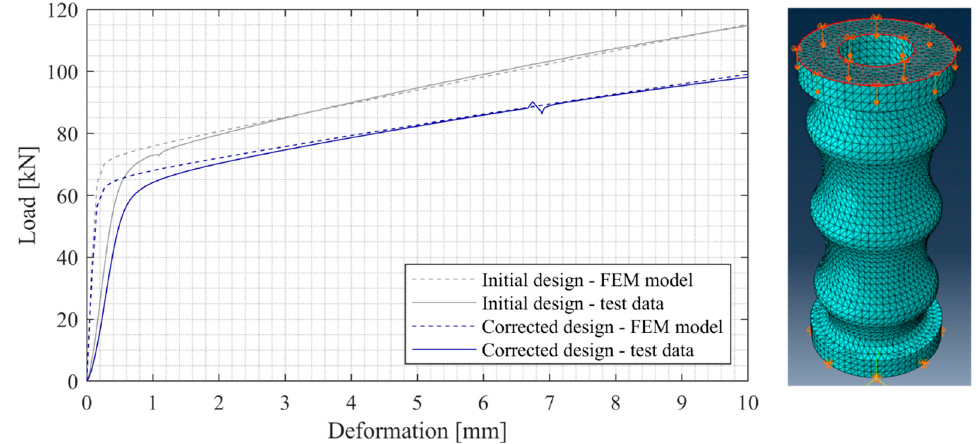
Figure 11. FE-simulation of the ductile unit.